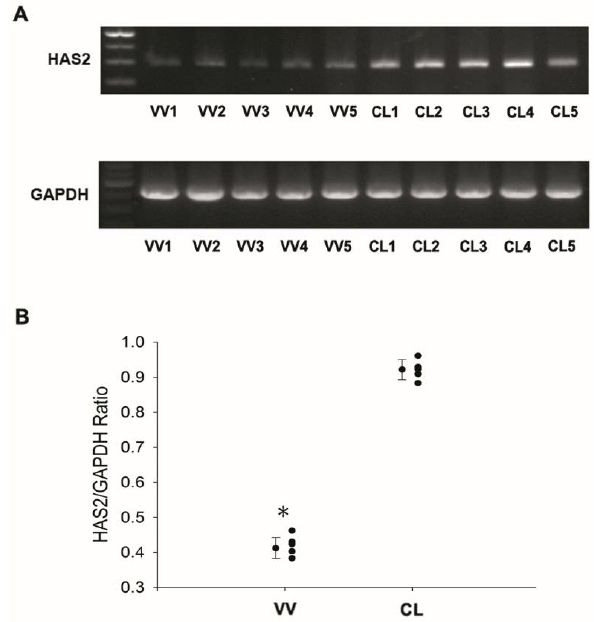
Figure 3. Expression of the hyaluronan synthases 2 gene ( HAS2 ) in venous samples from control patients (CL) and patients with varicose vein (VV). ( A ) Expression of HAS2 gene evaluated by reverse transcription polymerase chain reaction (RT-PCR); ( B ) Dot plot of quantification of RT-PCR product by densitometry. N = 5 for each group. * p < 0.05.